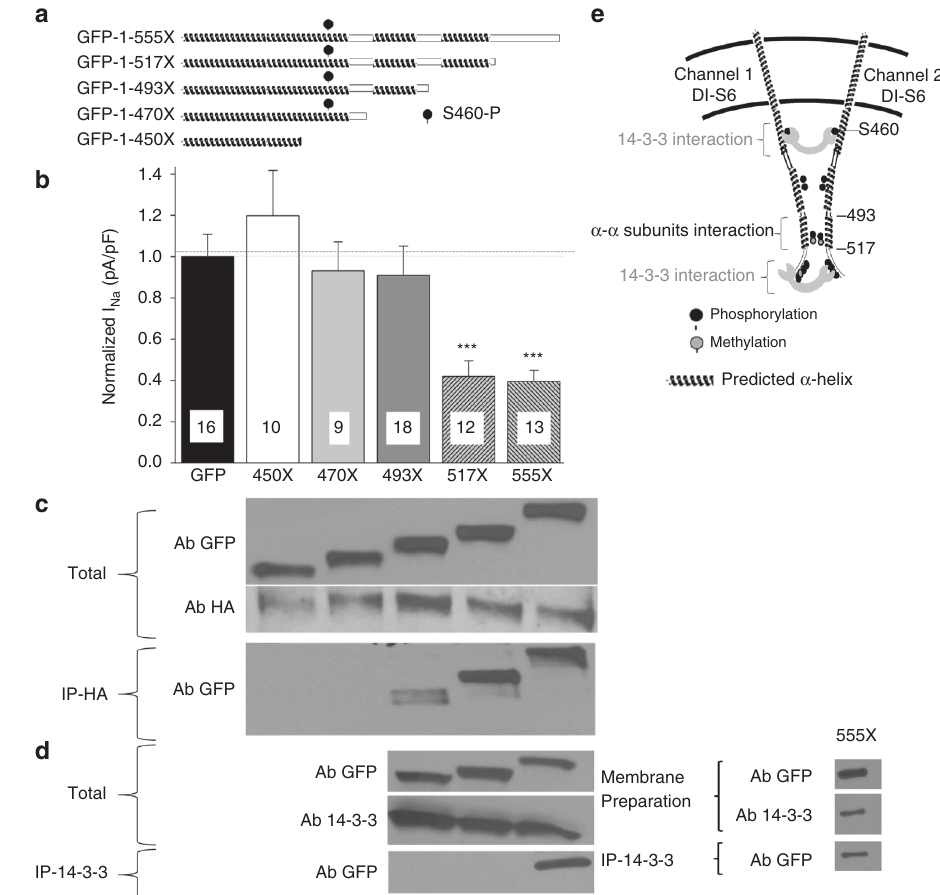
Fig. 2 Interaction site between sodium channel α -subunits is located between amino acids 493 – 517. a Schematic representation of the different truncated GFP-Na v 1.5. Constructs were generated from GFP-Na v 1.5, where GFP is tagged to the N-terminus. Truncations were generated by inserting a stop codon